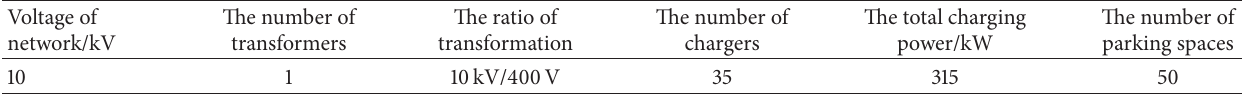
Table 1: The detailed information of the charging station.